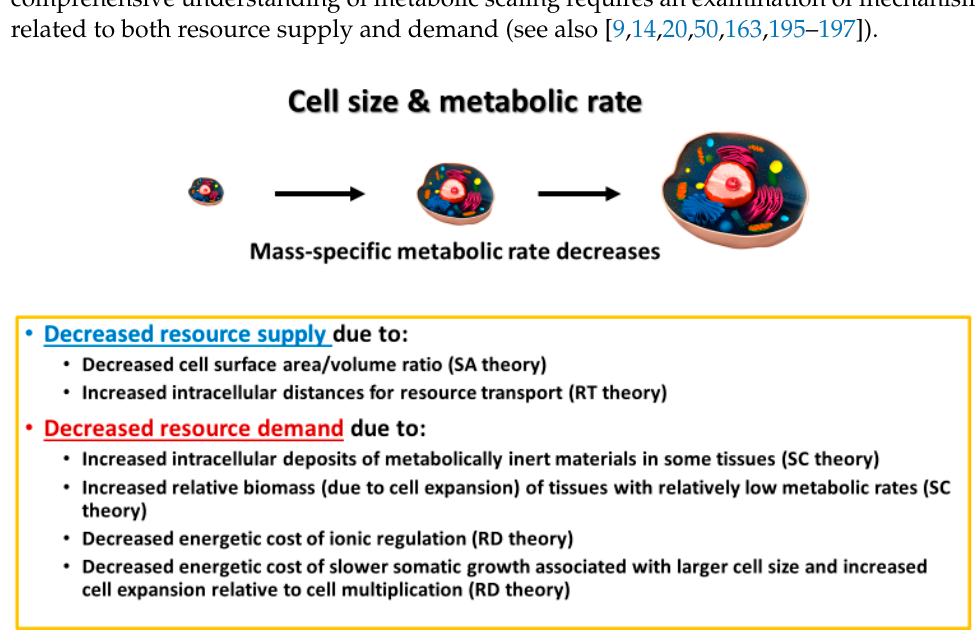
Figure 9. Summary of effects of cell size and expansion on mass-specific organismal metabolic rate, classified according to the major modal mechanisms of the contextual multimodal theory (CMT) of metabolic scaling [14,18], including surface area (SA) theory, resource transport (RT) theory, system composition (SC) theory, and resource demand (RD) theory. SA and RT mechanisms limit resource supply, whereas SC and RD mechanisms relate to resource demand. Cell picture from [198].